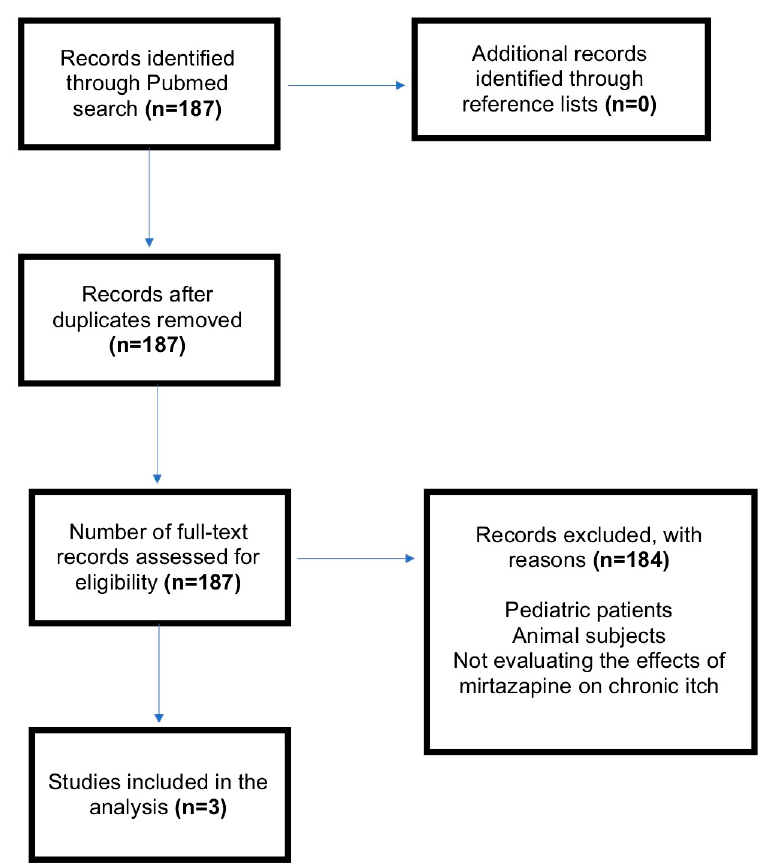
Figure 1. Preferred Reporting Items for Systematic Reviews and Meta-Analyses (PRISMA) flow-chart. n , number of articles; Mirtazapine